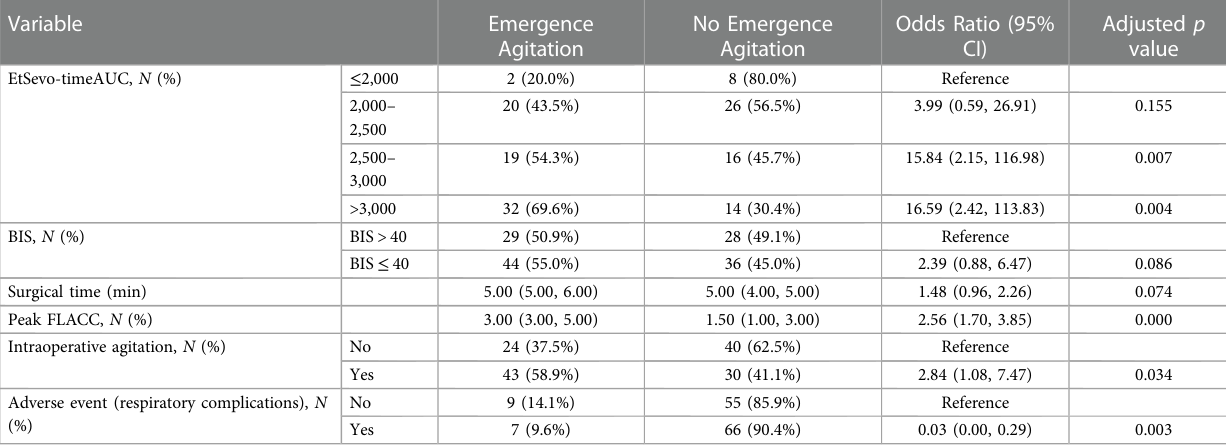
TABLE 3 Multivariable logistic regression model for emergence agitation. Variable